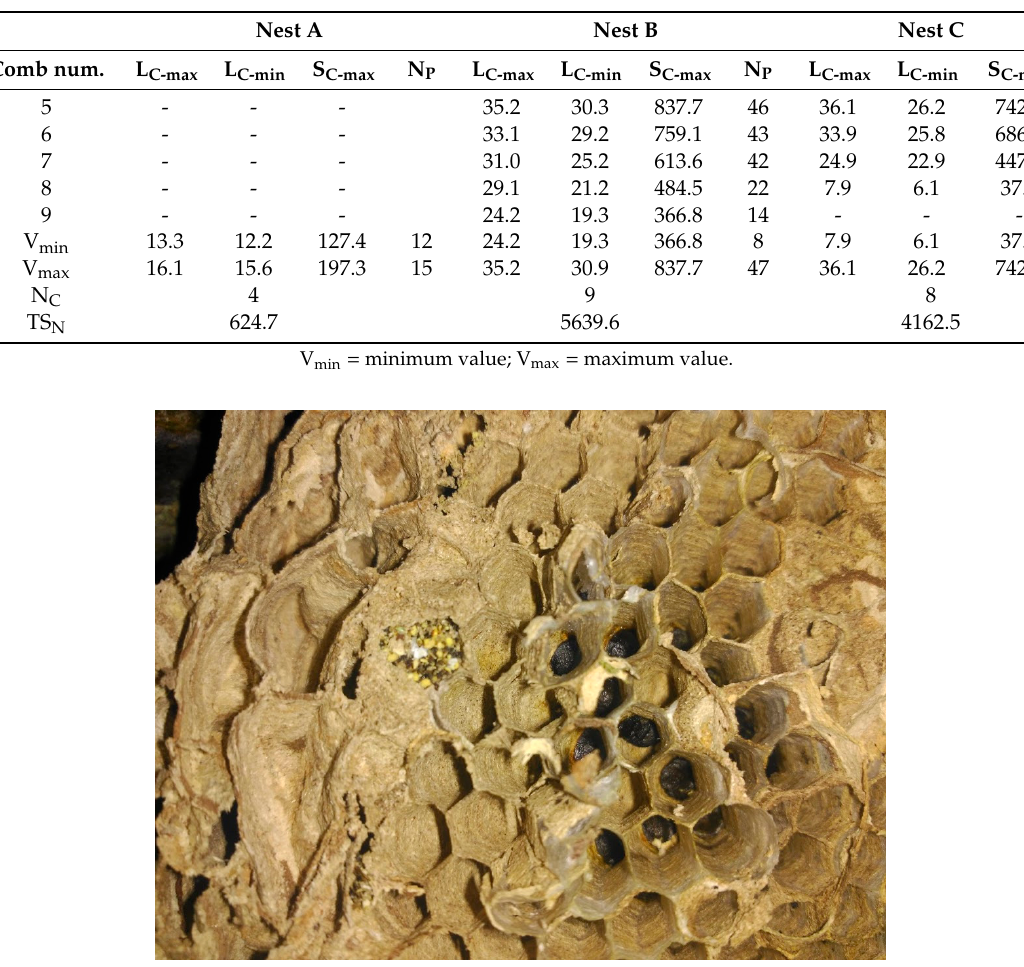
Table 2. Internal nest structural features. Number of the combs (N C ), with their maximum (L C-max ) and minor (L C-min ) length, and number of pillars (N P ). Surface of the combs (S C ). Total surface of the combs (TS C ). Total cells (TC N ) of V. velutina nests studied. Nest A Nest B Nest C Comb num.